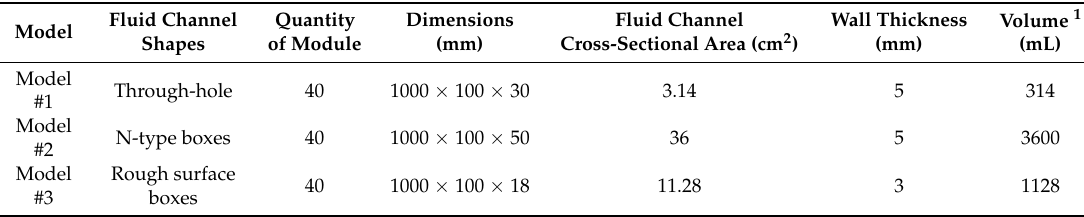
Figure 6. ( a ) Contact form between module and heat exchanger of Model #1 and #2; ( b ) Contact form between module and heat exchanger of Model #3. Table 1. The structure comparison of Models #1, #2 and #3.